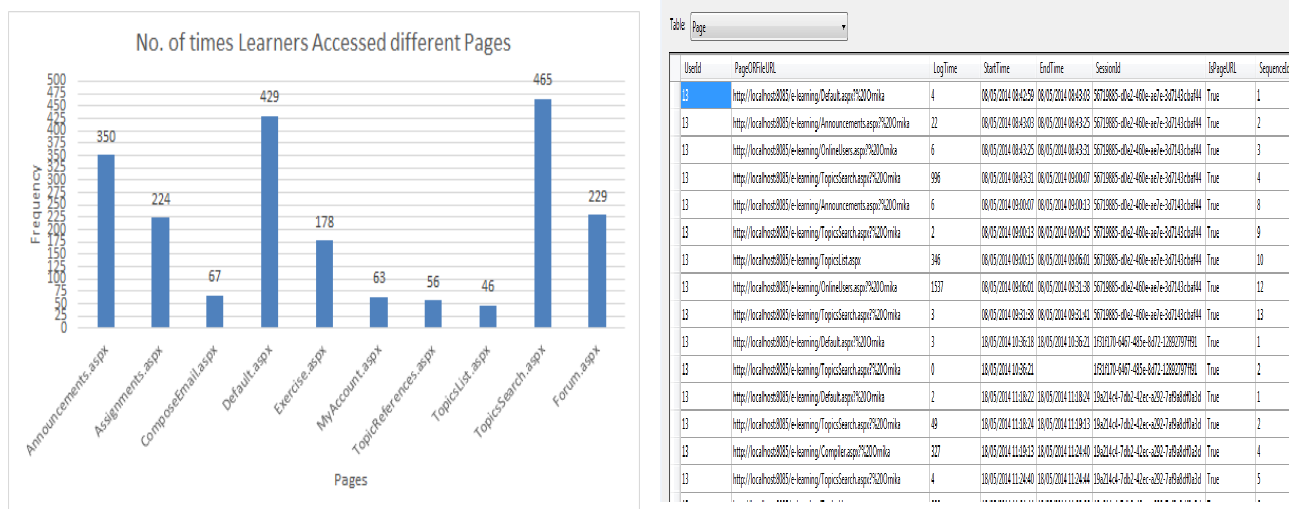
Figure 4. Analysis of Number of Times Learners Accessed